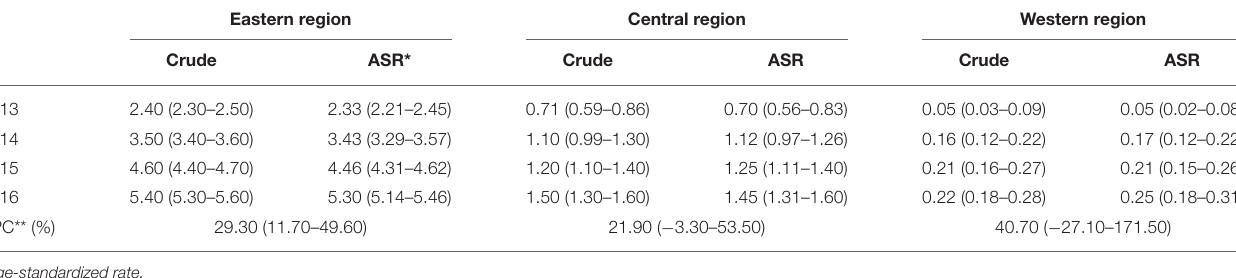
TABLE 11 | Annual crude and age-standardized prevalence rate of Crohn’s disease among urban employees in three regions of China from 2013 to 2016 (per 100,000 persons). Eastern region Central region Western region Crude ASR* Crude ASR